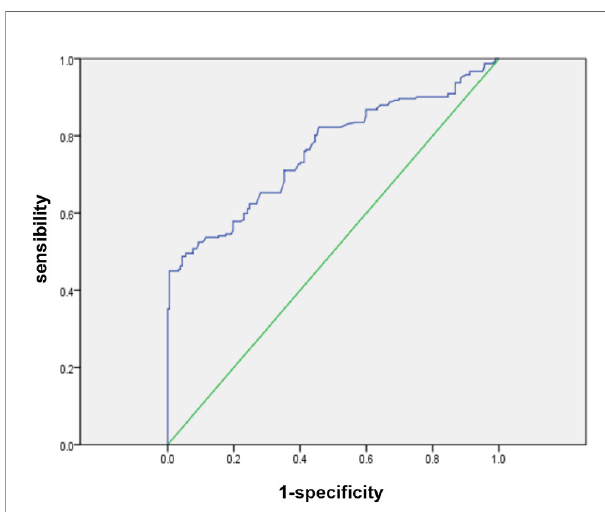
FIGURE 1 | ROC curves for NLR in patients with PDAC (NLR, neutrophil-to- lymphocyte ratio; PDAC, pancreatic ductal adenocarcinoma).